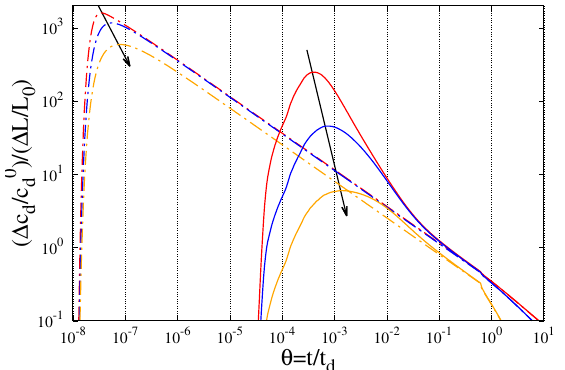
) vs θ for De = 0 d